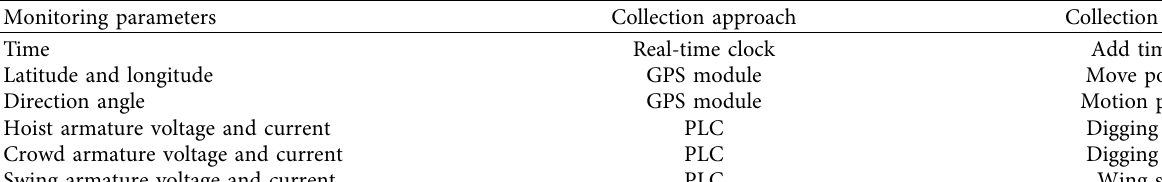
Table 1: The shovel monitoring parameters.